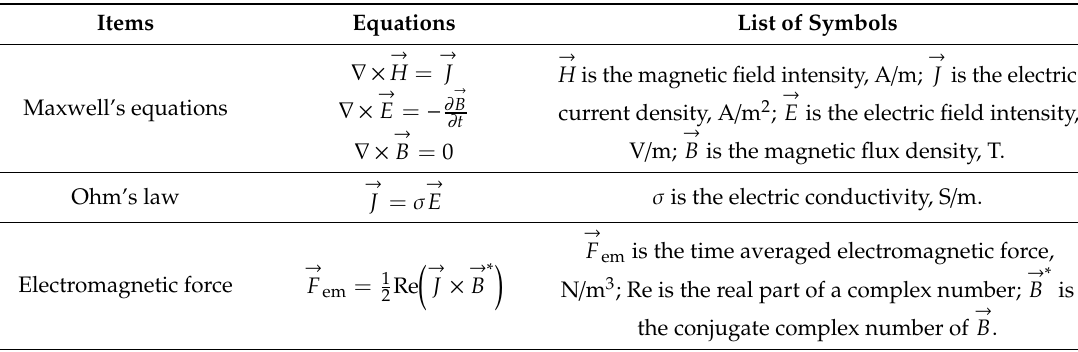
Table 1. Governing equations of electromagnetic